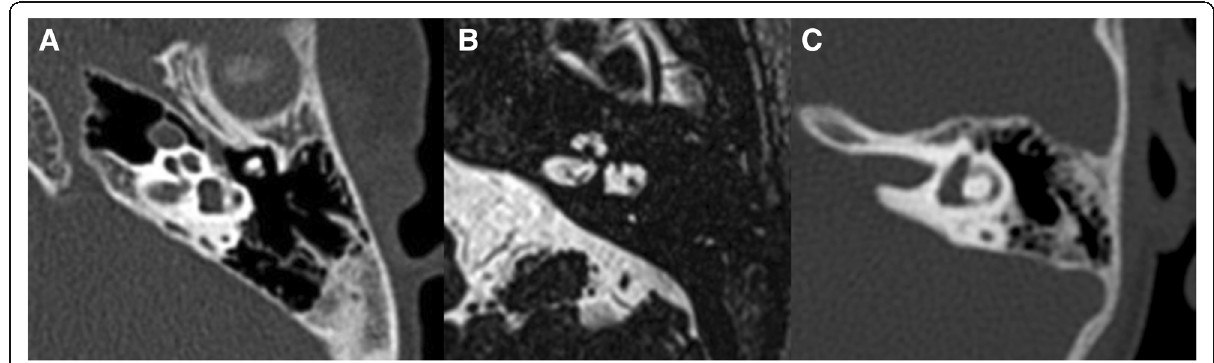
Fig. 8 Temporal bone CT ( a ) and MRI (axial T2/3D) ( b ) from a 2-year-old Down syndrome patient at the level of the lateral semi-circular canal, revealing left hypoplastic bone island (less than 3 mm in greatest diameter). Axial temporal bone CT ( c ) at the same level of a normal 2-year-old boy for